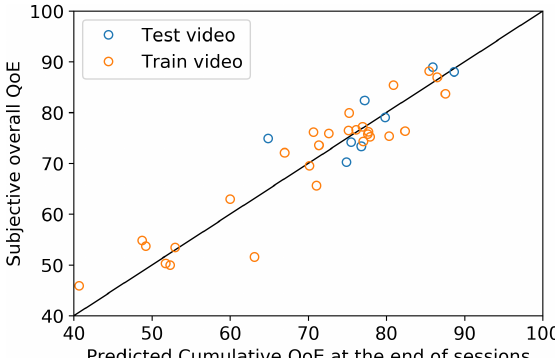
Figure 8. Correlation between subjective overall QoE and predicted cumulative QoE at the end of streaming session.